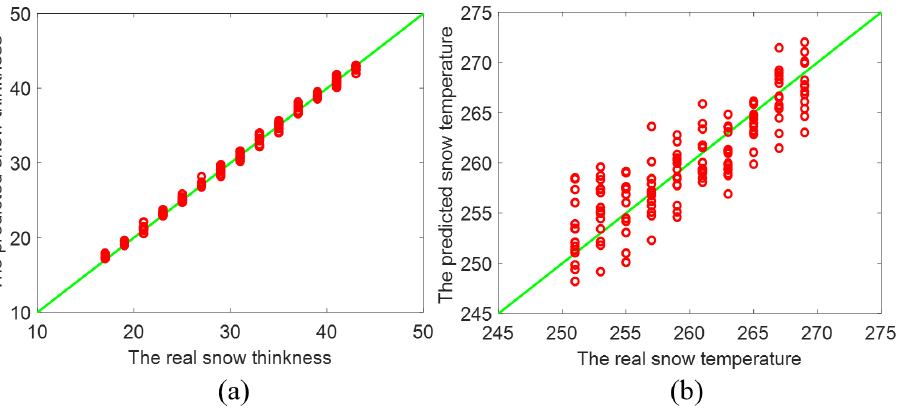
Figure 4. Inverted result of ( a ) the thickness and ( b ) the temperature of the snowpack by the proposed ConvNet